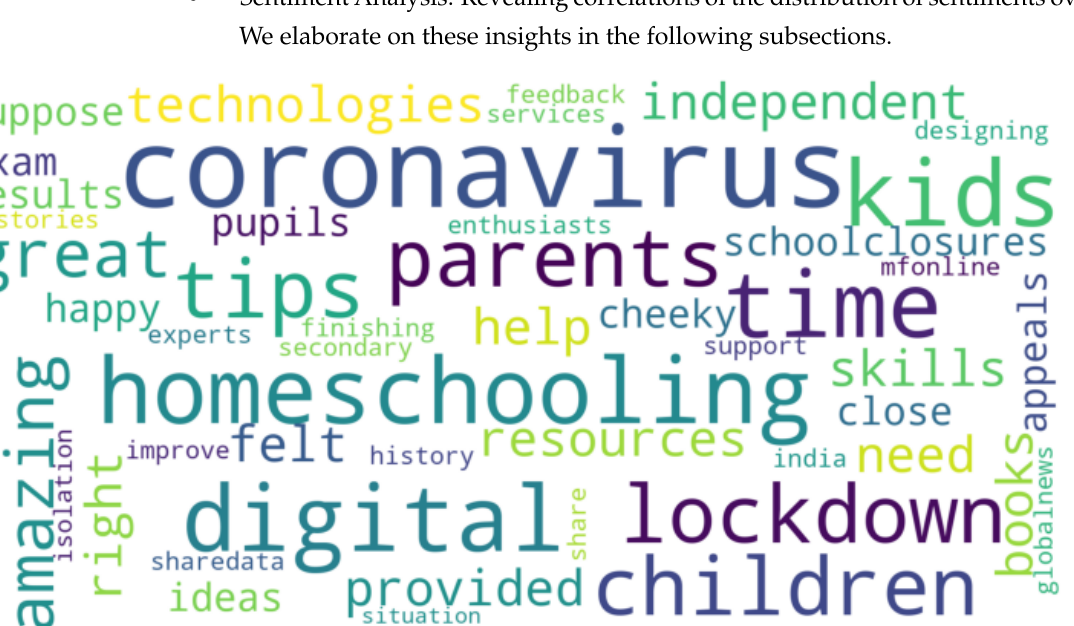
Figure 3. Word cloud for top 50 prevalent words